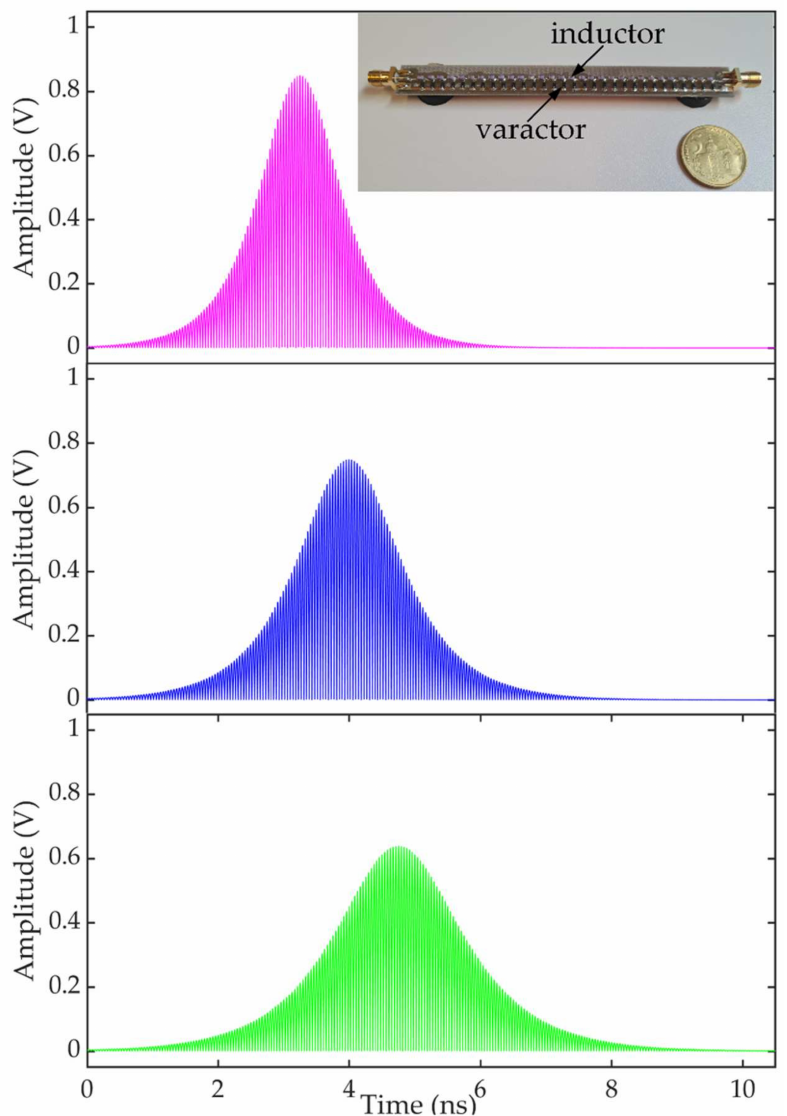
Figure 8. Voltage waveform of the bright soliton at three different nodes of the lossy NLTL: the upper, middle and bottom traces correspond to nodes 10, 20, and 30, respectively. Insets show the fabricated NLTL prototype with 30 identical